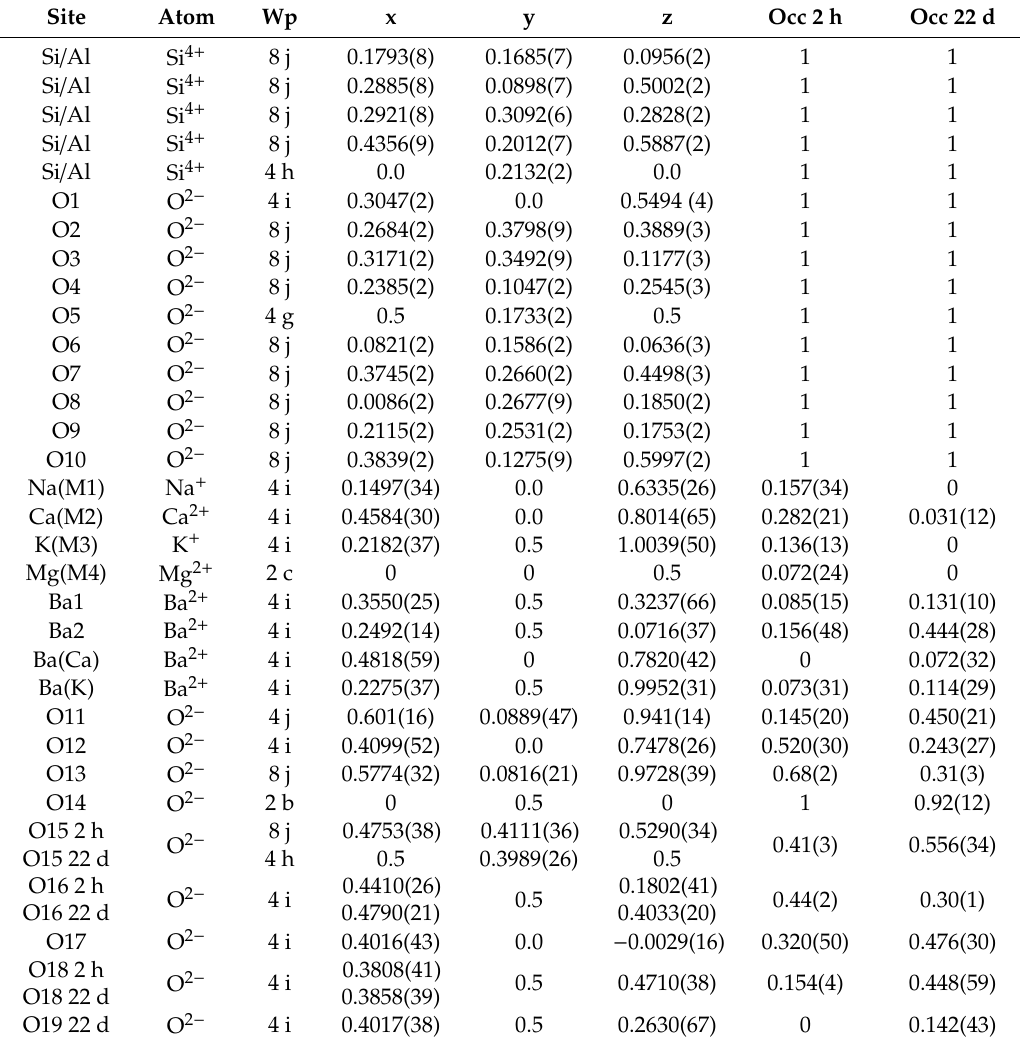
Table 5. Wycko ff positions (Wp), atomic coordinates, and occupancy factors of samples